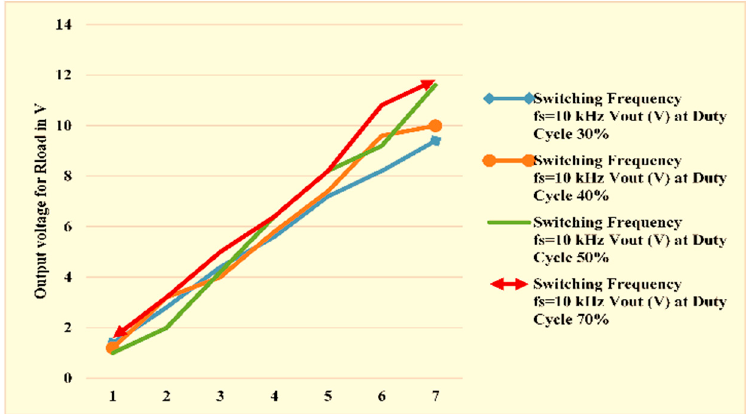
Figure 12. Output voltage comparison at different duty cycles and f s = 10 kHz.